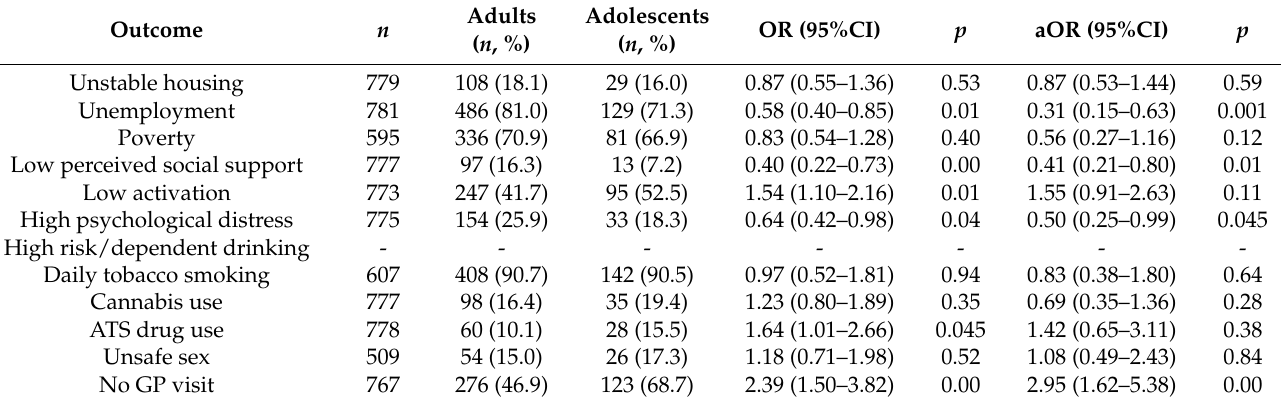
Table 1. Associations between age and key outcomes at 1 month follow-up.